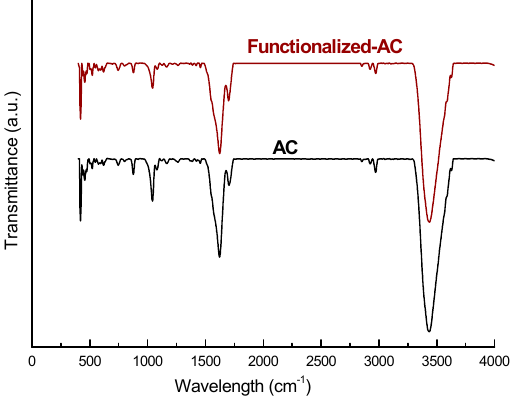
Figure 3. Fourier transform infra-red (FT-IR) spectra obtained for AC and functionalized-AC.